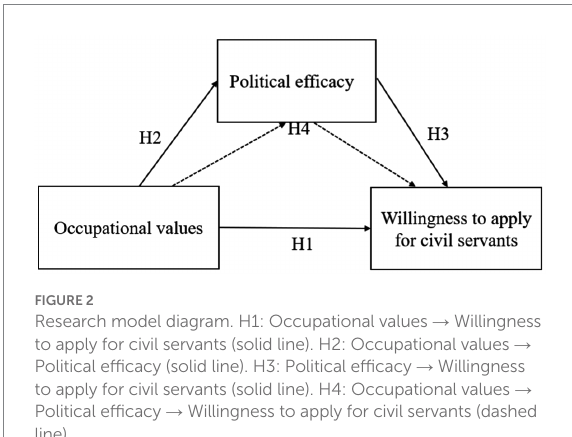
FIGURE 2 Research model diagram. H1: Occupational values → Willingness to apply for civil servants (solid line). H2: Occupational values → Political efficacy (solid line). H3: Political efficacy → Willingness to apply for civil servants (solid line). H4: Occupational values → Political efficacy → Willingness to apply for civil servants (dashed line).